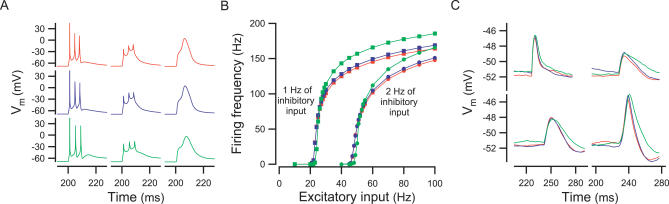
Comparison of the Models with the Data for Synaptic ResponsesData (red lines), best (blue lines), and worst (green lines) model of our selection are compared for different synaptic responses.(A) Complex spike in the soma (left), main dendrite (middle), and smooth dendrite (right) after activation of the climbing fiber at time 0.2 s.(B) Simple spike frequency response to different levels of excitation and inhibition.(C) EPSPs generated by a synchronous parallel fiber input plus an asynchronous background excitation and inhibition. EPSPs are generated in four different branchlets and recorded at the soma, which is passive. The traces show the average of 40 EPSPs obtained with different random number generator seeds.